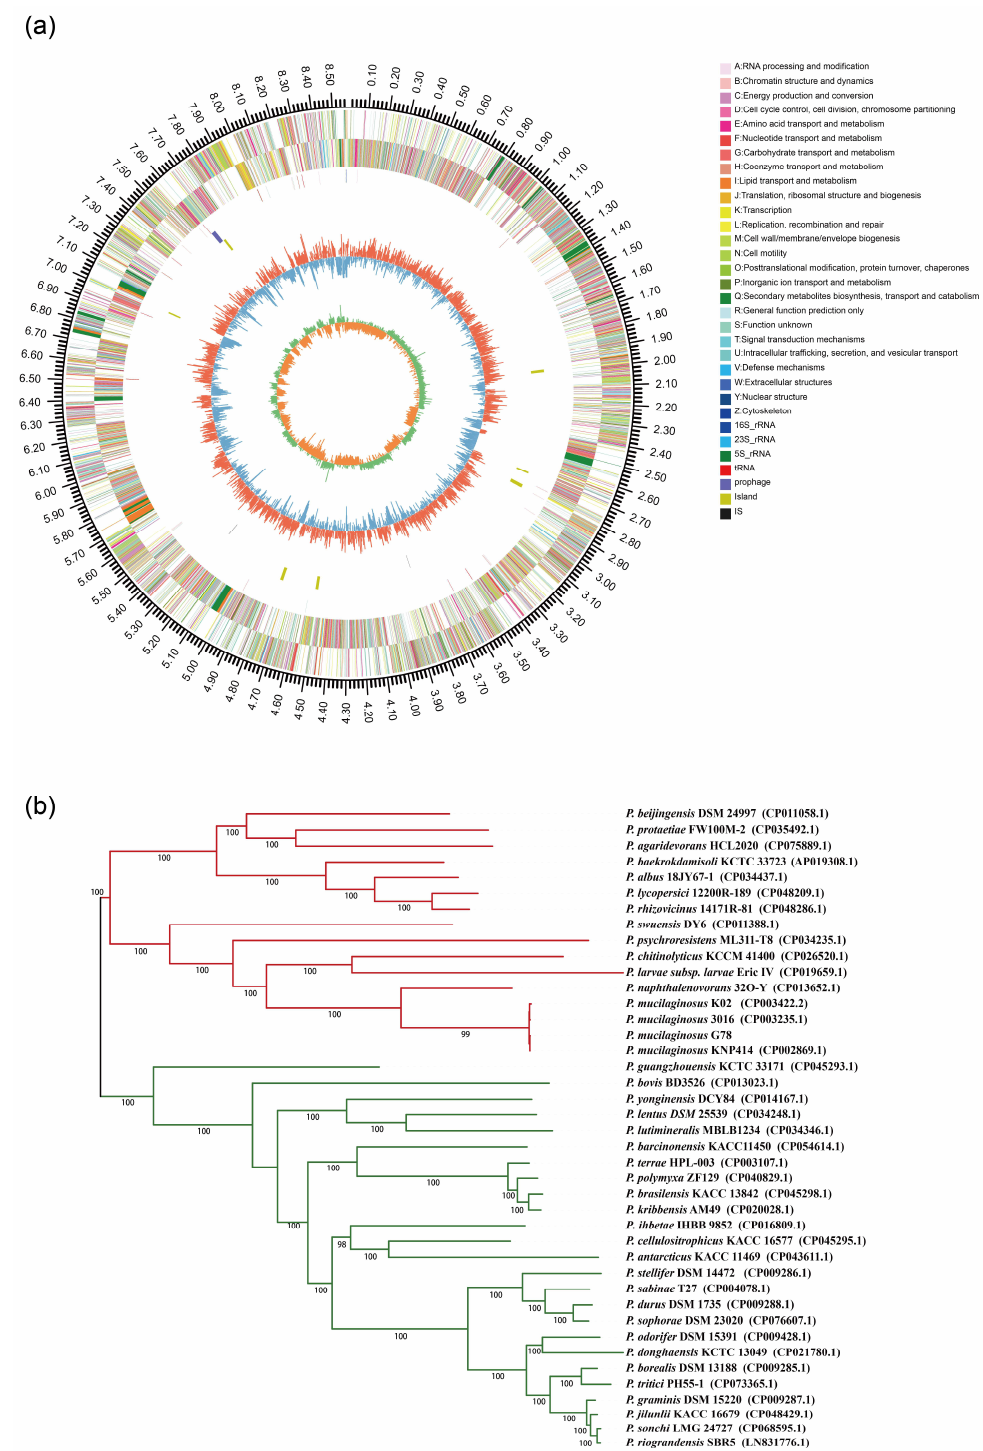
Figure 2. Genomic features of P. mucilaginosus G78 and phylogenetic relationship of 41 Paenibacillus strains. ( a ) Genome map of P. mucilaginosus G78. Circles (from outside to inside) as follows: (1) scale marks (unit, Mb), (2) protein-coding sequences on the forward strand colored by COG category, (3) protein-coding sequences on the reverse strand (same color scheme as the second circle), (4) rRNA genes, (5) tRNA genes, (6) GC content (deviation from average), and (7) positive (green) and negative (orange) GC skew. ( b ) ML phylogenetic tree was constructed using based on 309 single-copy core proteins shared by 41 genomes.